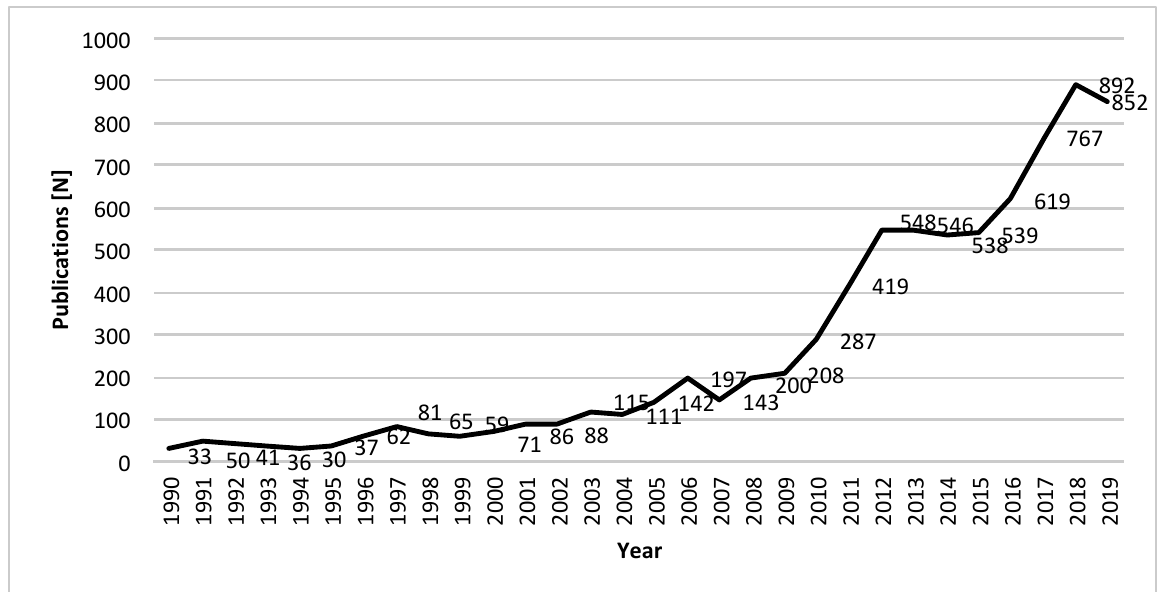
Figure 1. Scientific productivity of research in physical education measured by the number of publications: Source: Own study based on data retrieved from the Scopus (05 January 2020). Table 3. General publication profiling of the physical education research field